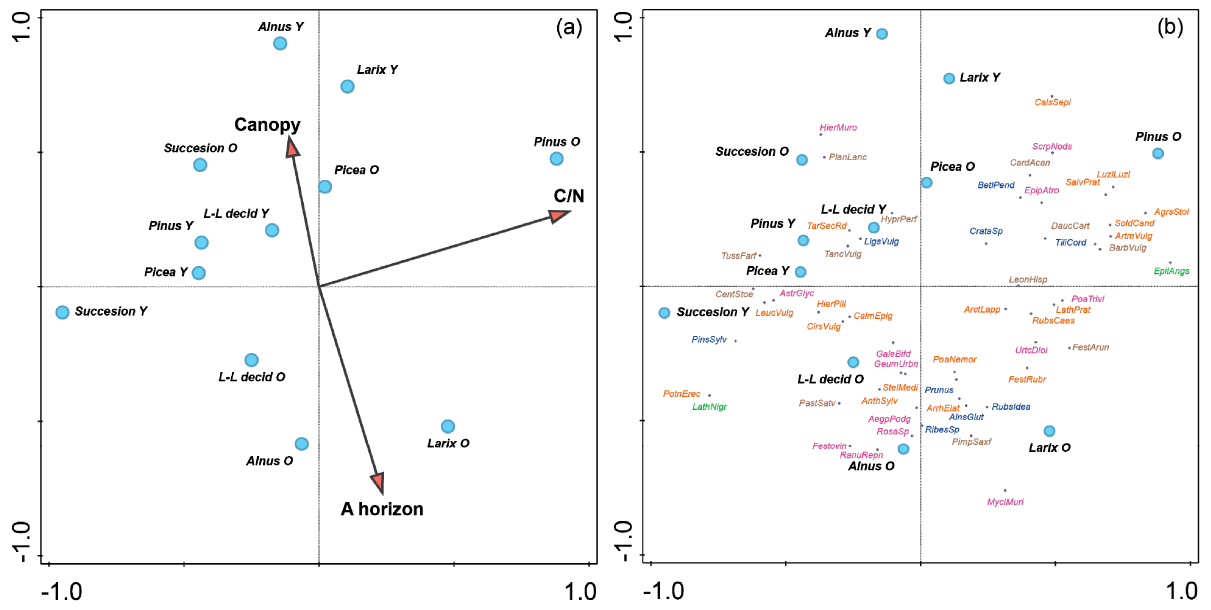
Figure 8. CCA with supplementary variables (forest type and age). Total explanatory variables account for 13.25%. The first ordination axis included 37.99% of the data variability, and the second included 35.25%. Blue points indicate forest types differentiated by age (Y—younger, O—older), the abbreviation L–L decid indicates long-lived deciduous trees. ( a ) CCA with supplementary variables (forest type) with environmental variables (humus, canopy, C/N ratio); ( b ) CCA with supplementary variables (forest type) with species context. The 55 most fitting species are listed. Species dif-